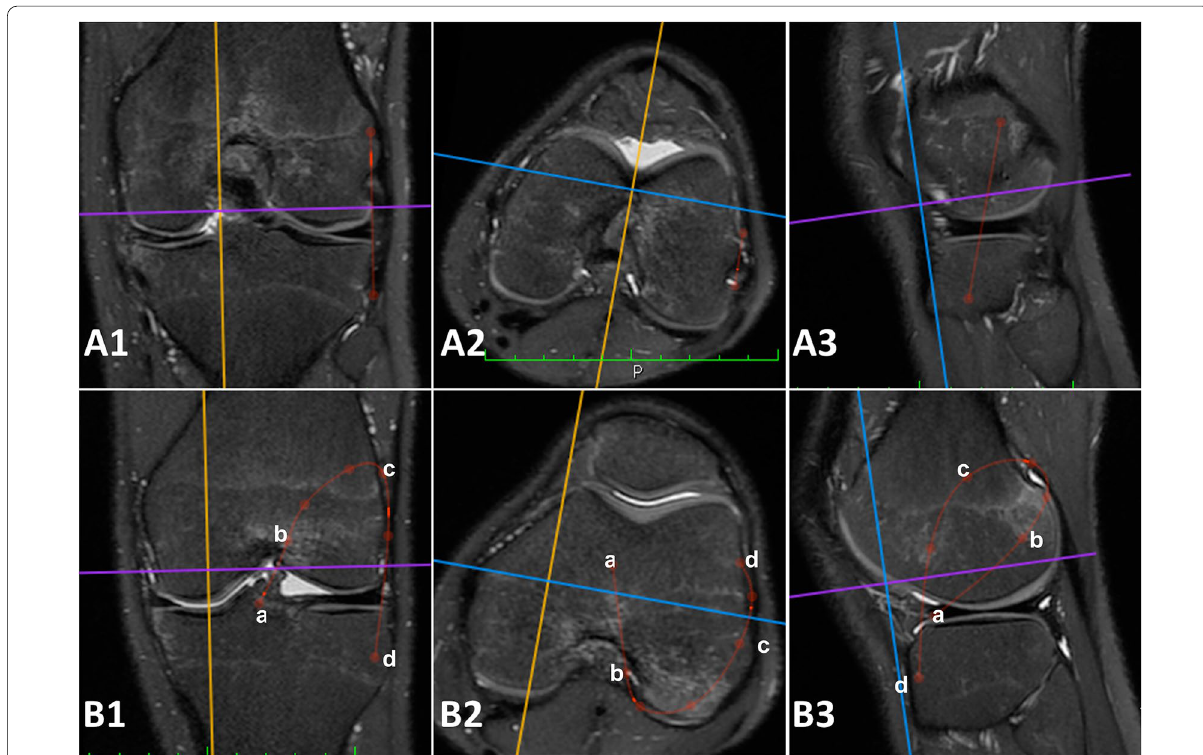
Fig. 3 3D measurements performed on the 3D MRI sequences (Turbo Spin Echo T2 weighted 3D MRI with isotropic voxel). A Red lines: anatomic anterolateral ligament (ALL) reconstruction defined as the distance from a point located 5 mm proximal and 5 mm posterior to the apex of the lateral femoral epicondyle and a tibial point equidistant between the center of the Gerdy’s tubercle and the anterior margin of the fibular head, 9.5 mm distal to the joint line. Particularly, A1 is the coronal view, A2 is the axial view, and A3 is the sagittal view of a left knee with simulation of the same reconstruction. B Red lines: Marcacci technique (MT) defined as defined as the ACL graft path of the Marcacci technique, passing through a the center of the tibial ACL footprint; b the over the top femoral position; c the distal aspect of the proximal ridge of the femur at the diaphyseal-metaphyseal junction; d the Gerdy’s tubercle. Particularly, B1 is the coronal view, B2 is the axial view, and B3 is the sagittal view of a left knee with simulation of the same